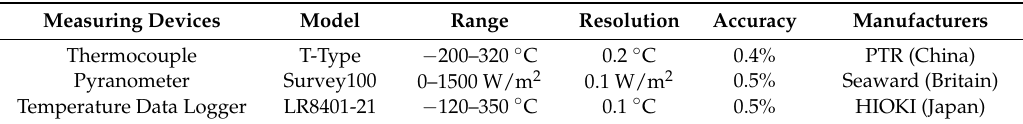
Table 3. The technique data for the measuring